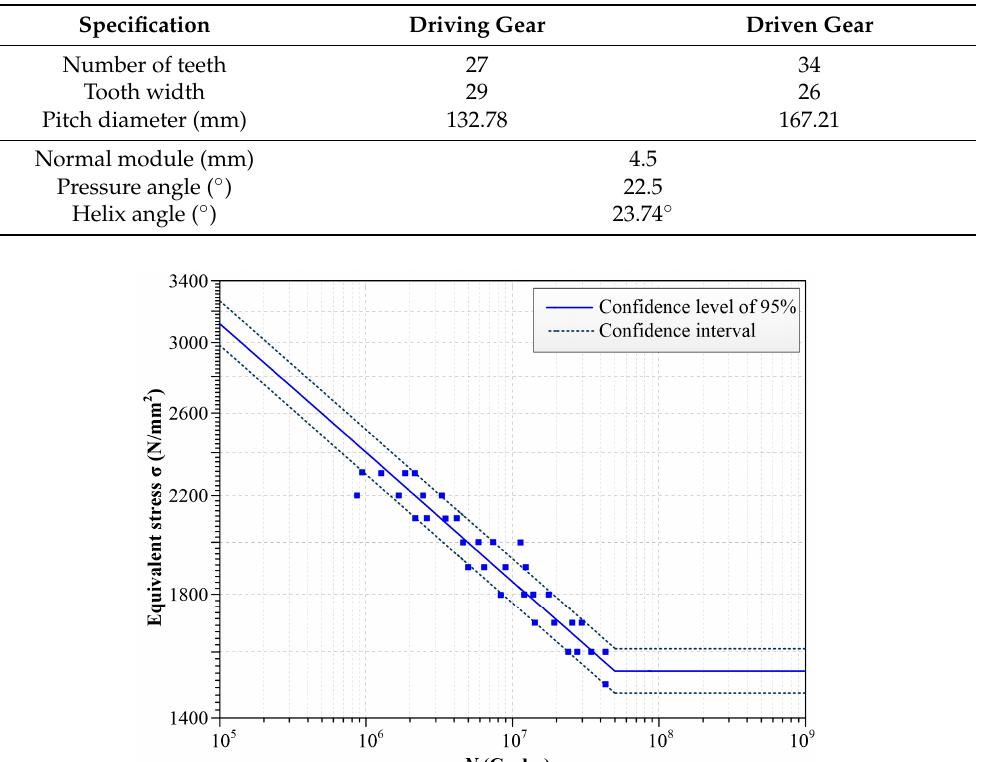
Table 2. Details of the gears.